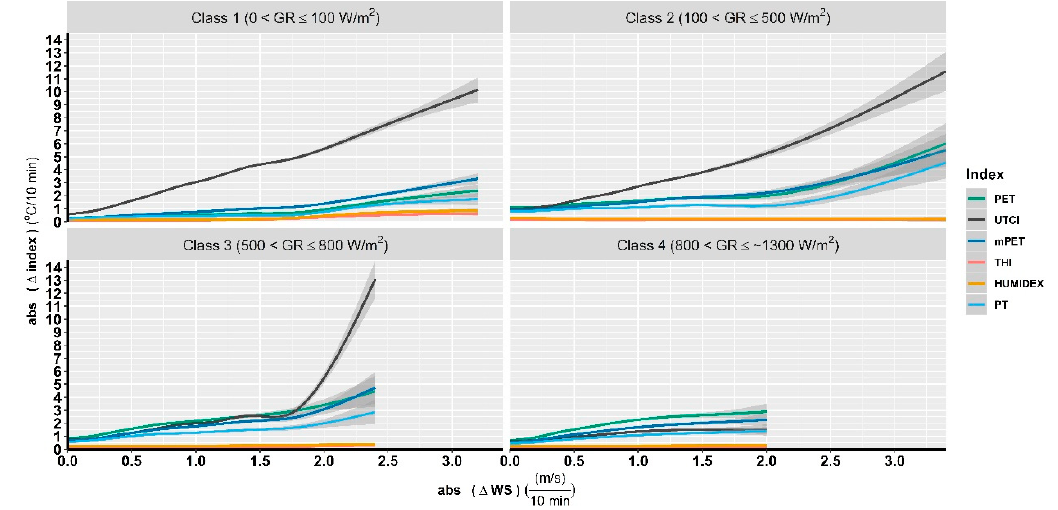
Figure 9. The sensitivity of the indices to wind speed (WS) change rate under different global radiation (GR) conditions.